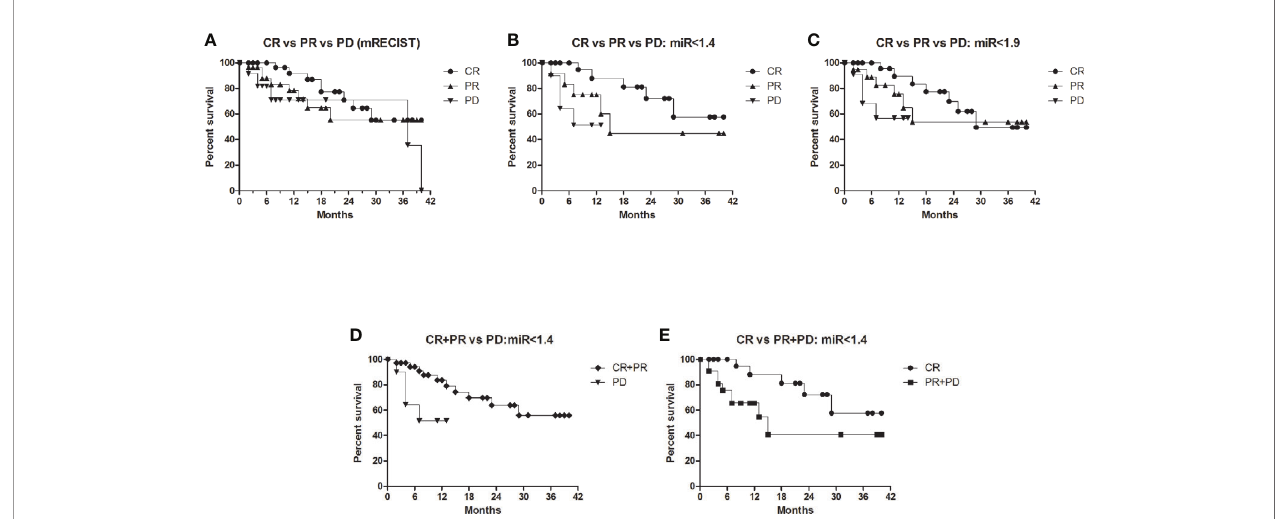
FIGURE 5 | Survival curve comparison of CR, PR, and PD patients at 42-months post-LRT with miR-21 fold change. Comparison among CR vs. PR vs. PD as per mRECIST criteria in all HCC patients (A) , HCC patients with miR-21 FC cut off value < 1.4 (B) , HCC patients with miR-21 FC cut off value < 1.9 (C) , HCC patients with miR-21 FC cut off value < 1.4 in group 1, CR + PR vs. PD (D) , HCC patients with miR-21 FC cut off value < 1.4 in Group 2, CR vs.PR + PD (E)